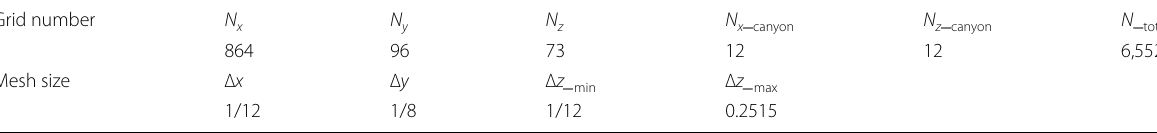
Table 1 Spatial discretization of the computational